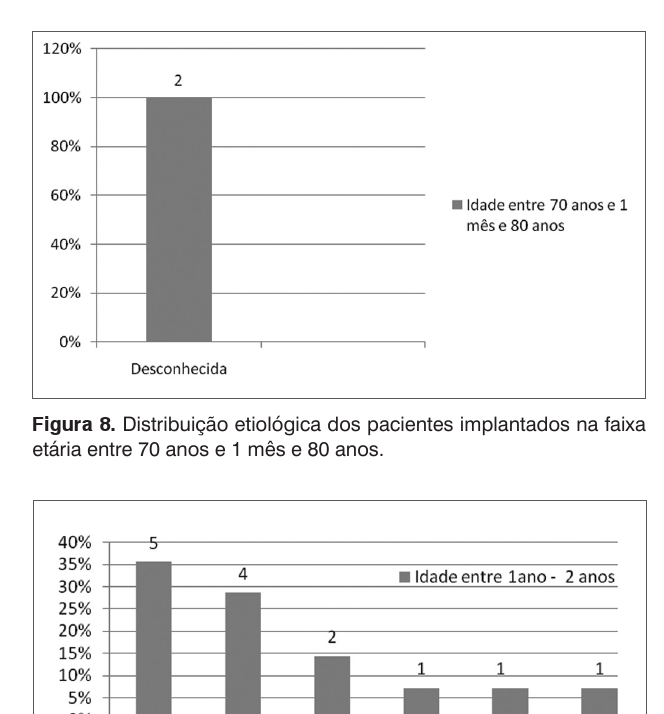
Figura 7. Distribuição etiológica dos pacientes implantados na faixa etária entre 30 anos e 1 mês e 40 anos.